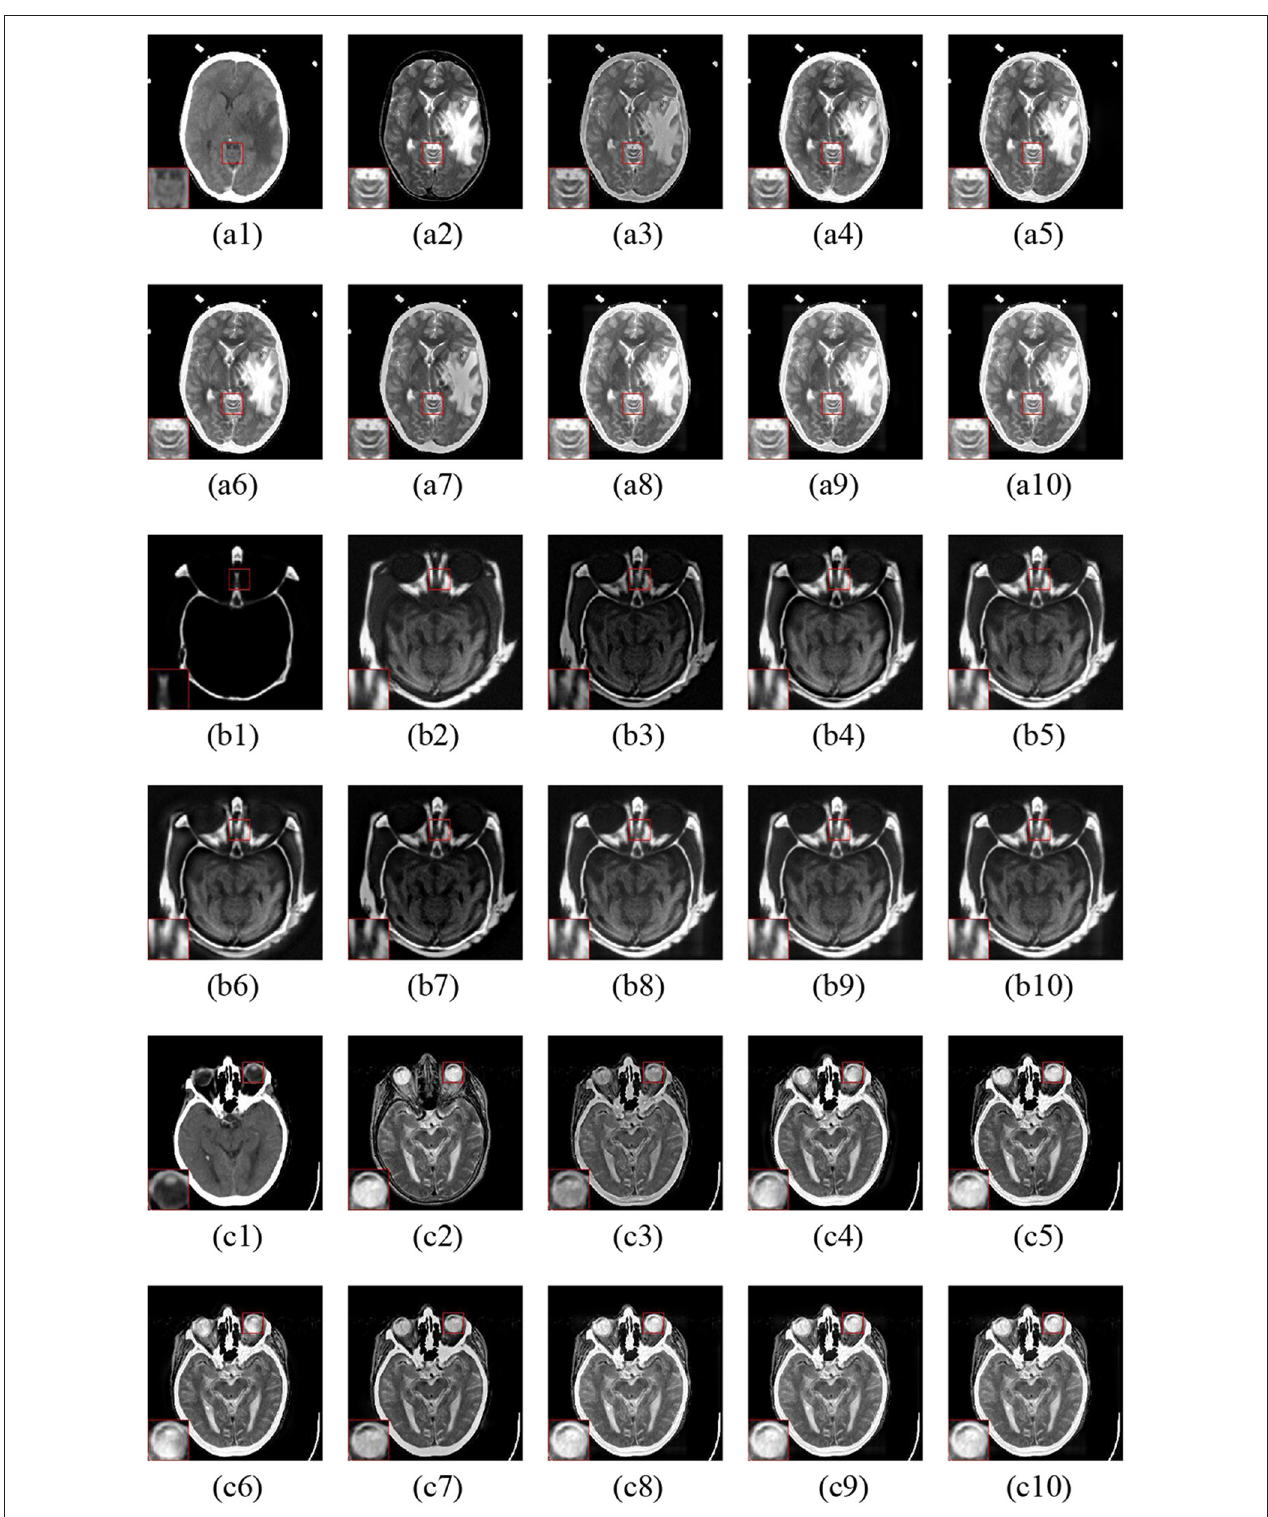
FIGURE 6 | Three fusion examples of CT and MR images. One close-up is provided in each set for better comparison. The original images: (a1–c1) CT and (a2–c2) MR. The fusion results (a3–c3) ASR, (a4–c4) NSCT-PC-LLE, (a5–c5) LP-CNN, (a6–c6) NSST-PAPCNN, (a7–c7) CSMCA, (a8–c8) LatLRR-FCN-32s, (a9–c9) LatLRR-FCN-16s, and (a10–c10) LatLRR-FCN-8s.